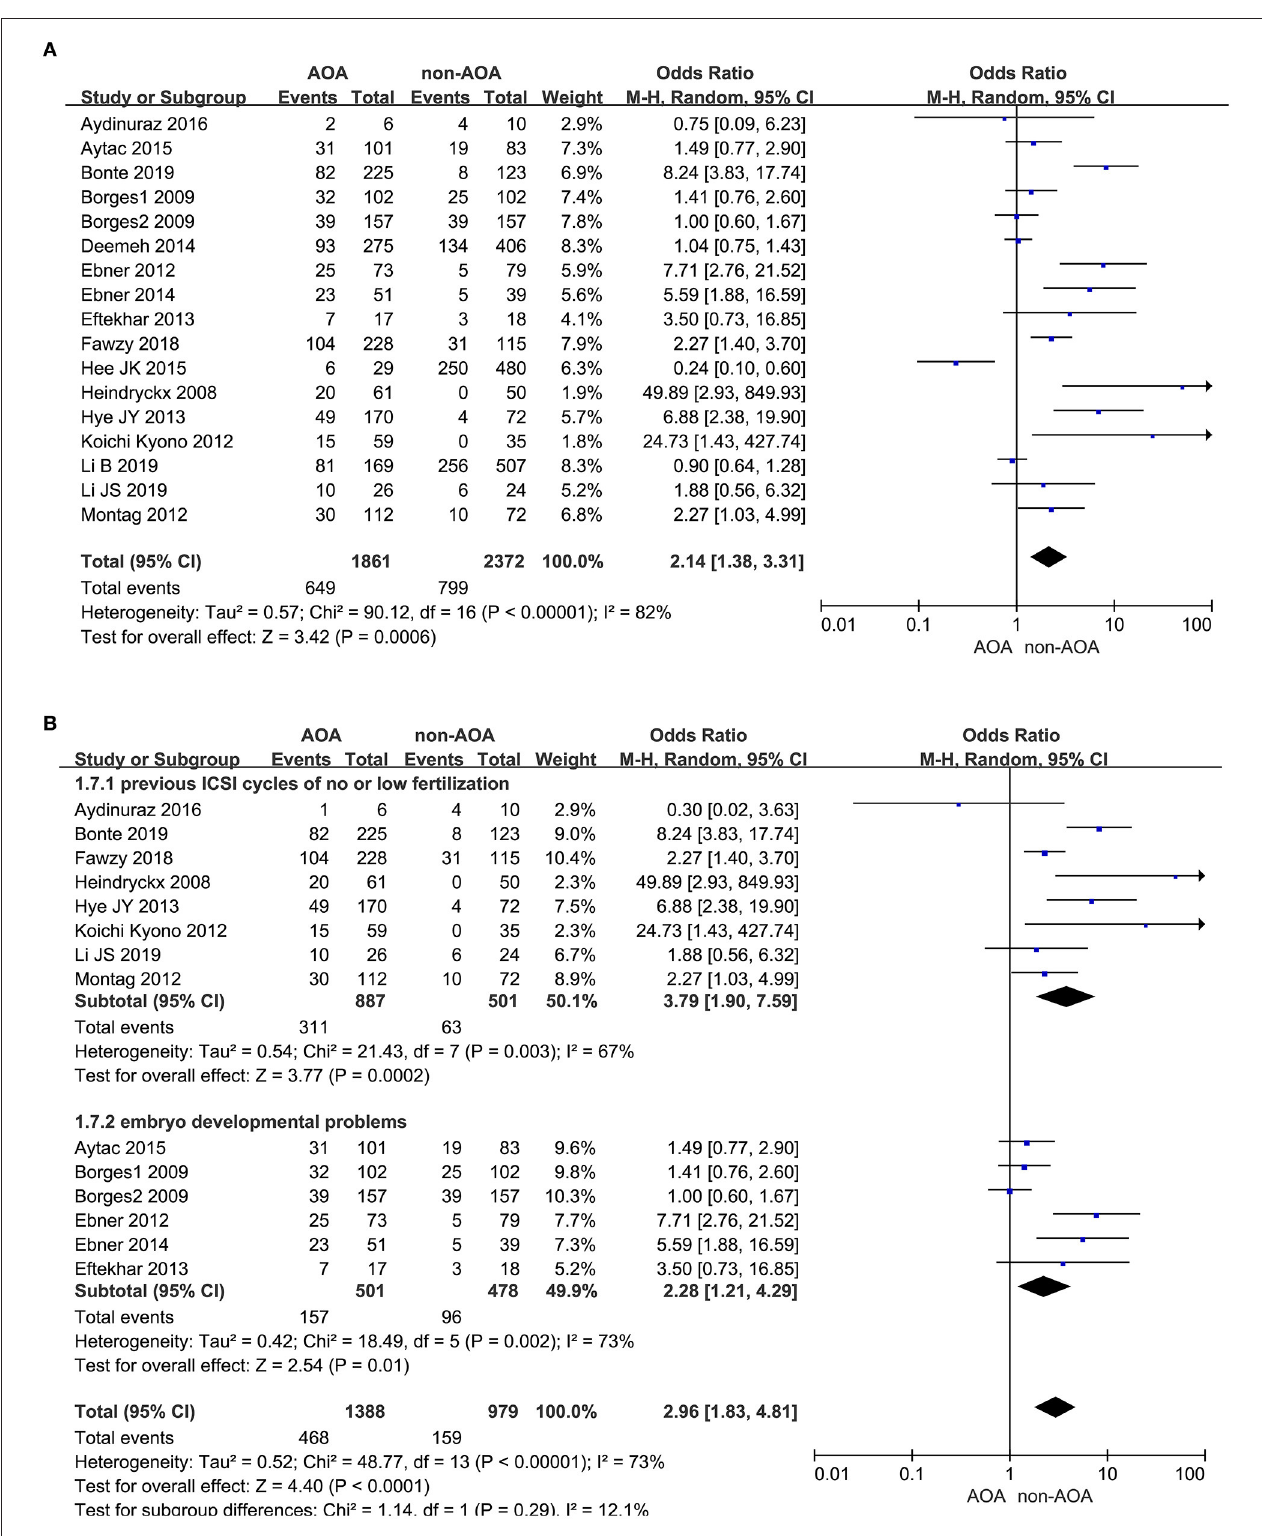
FIGURE 2 | (A) Forest plot of pregnancy rate between AOA treatment and non-AOA treatment patient groups using calcium ionophore. (B) The subgroup analysis of pregnancy rate between AOA treatment and non-AOA treatment patient groups.